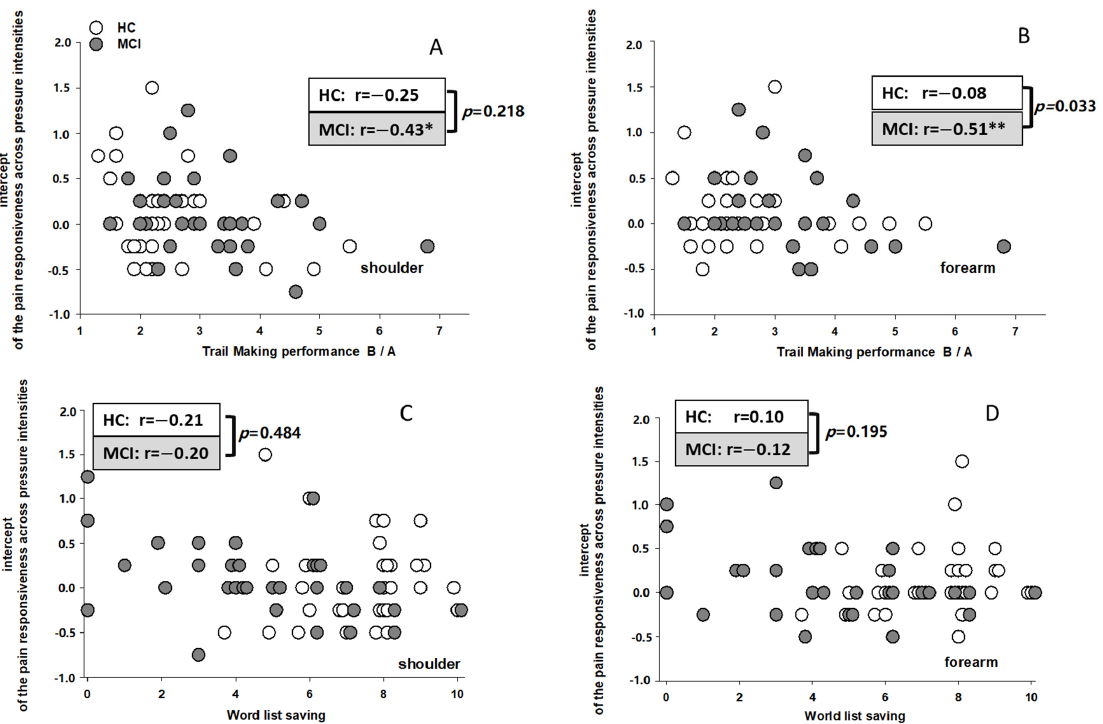
Figure 3. Associations between the onset of pain perception (intercept) and executive functioning (TMT-B/A) (top row) and memory function (word list saving) (bottom row) for the two stimulation sites (( A , C ) shoulder; ( B , D ) forearm). The different groups (HC, MCI) are displayed in different shades of grey. Partial correlation coefficients (r-values) are displayed separately for each group. Significant r-values are specified by * ( p < 0.05) and ** ( p < 0.01). The p -values refer to the comparison of correlation coefficients between groups using z-statistics.